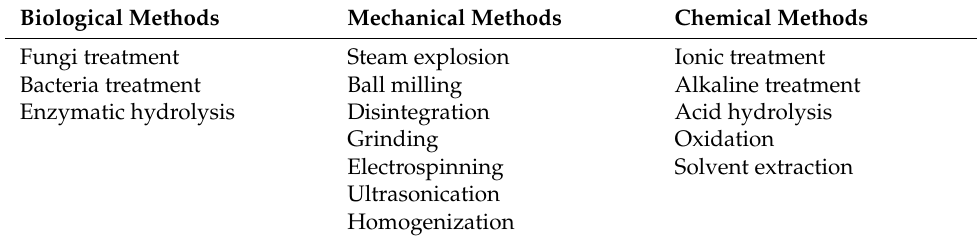
Table 2. Nanocellulose isolation